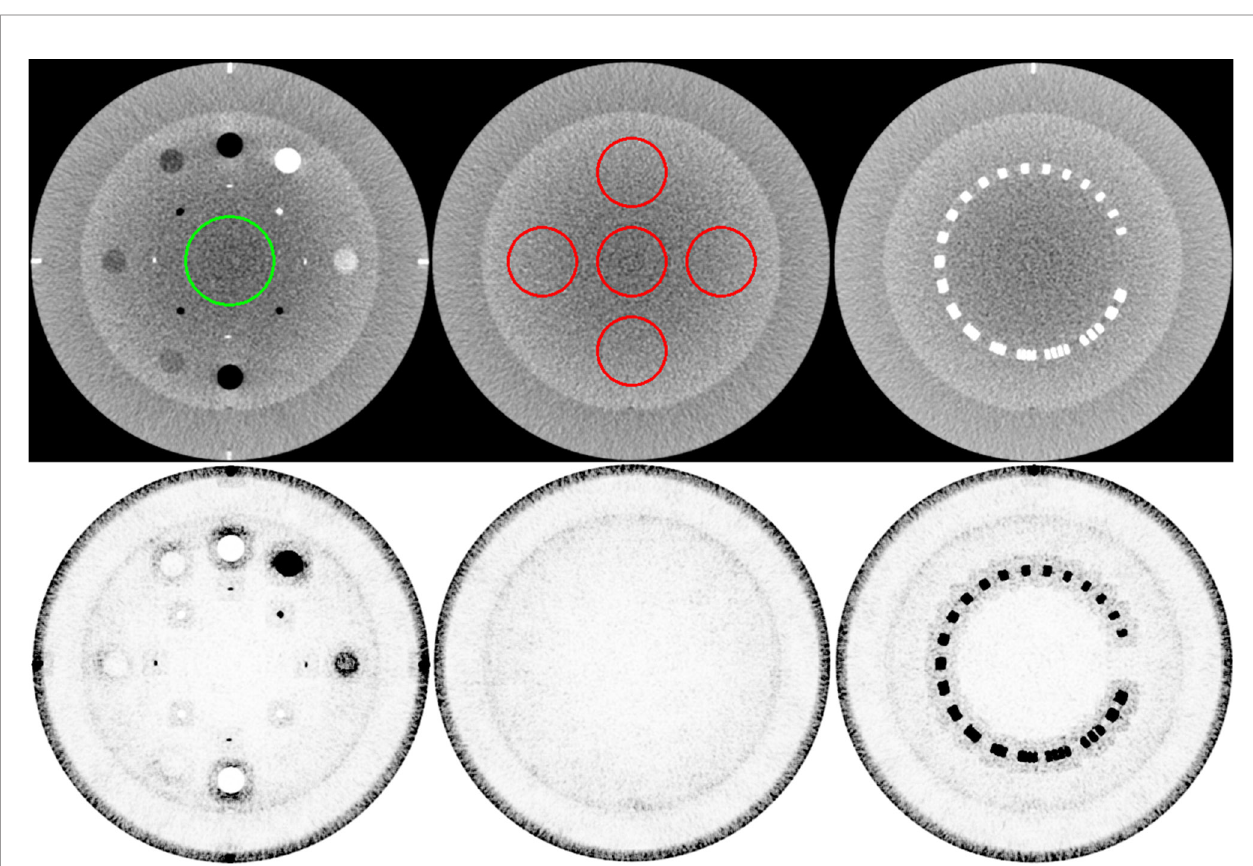
FIGURE 1 | Weight map of the MI-NLTV denoiser that composes the MI-based statistical measure and the spatially encoded factor. The fi rst row shows the original image generated by applying the analytical reconstruction algorithm based on RDB. The ROI in the left image identi fi es the location of the background for CNR calculation, and the ROI in the middle is for SNU calculation. The second row shows the corresponding weight map. These weight maps are displayed at the window (width and level) settings of (0.2,